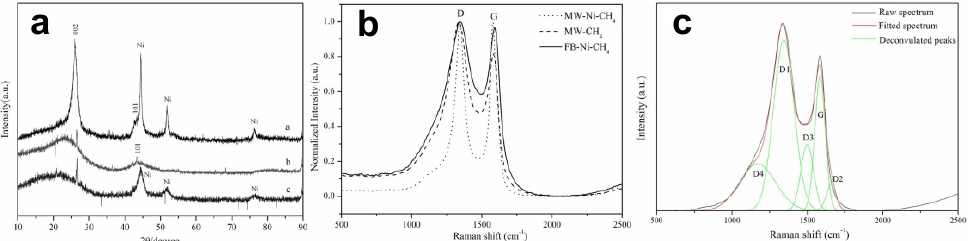
Figure 14. ( a ) X-ray diffraction pattern of pine nut shell (PNS) coke at 600 ◦ C: (i) nickel-containing catalyst during microwave radiation, (ii) nickel-free catalyst during microwave radiation, and (iii) nickel-containing catalyst in fixed bed; ( b ) normalized Raman spectra; ( c ) typical deconvoluted Raman spectra of carbon nanotubes (CNTs) [130]. Copyright © 2021 Elsevier B.V. and Diamond and Related Materials.